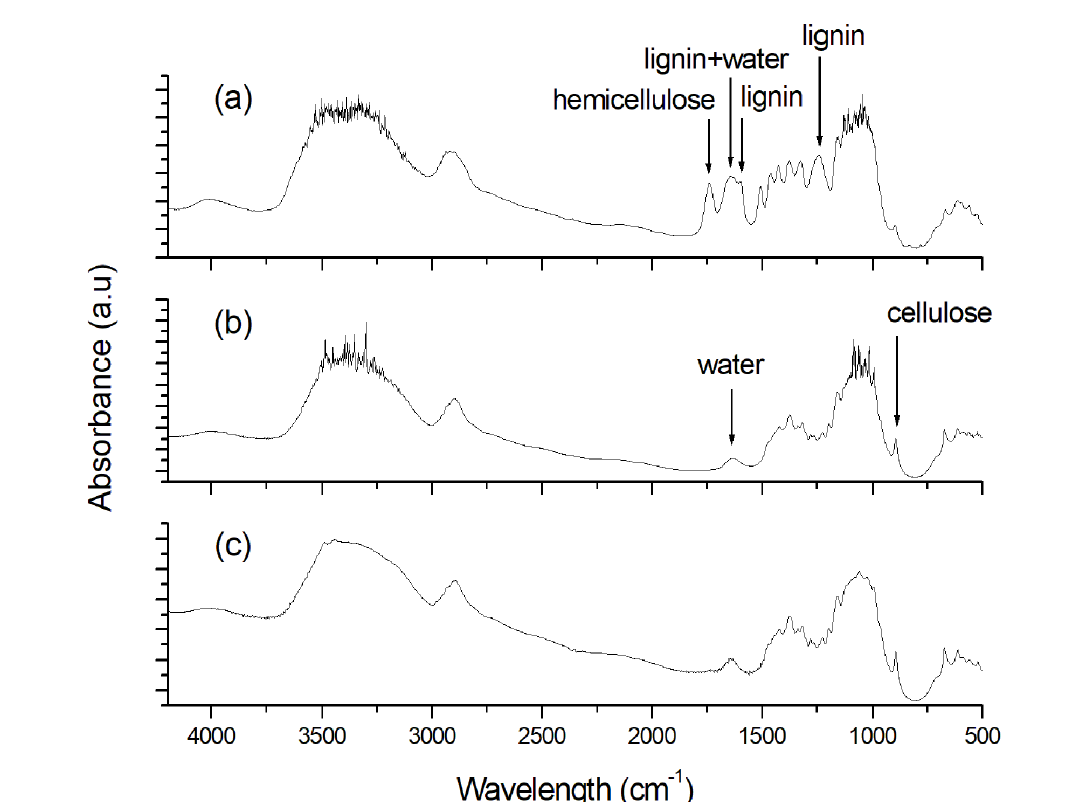
Figure 3. FTIR spectra of: Cereus Forbesii bark (a), cellulose obtained by alkaline treatment (b), and cellulose nanofibers obtained by the acid hydrolysis of cellulose